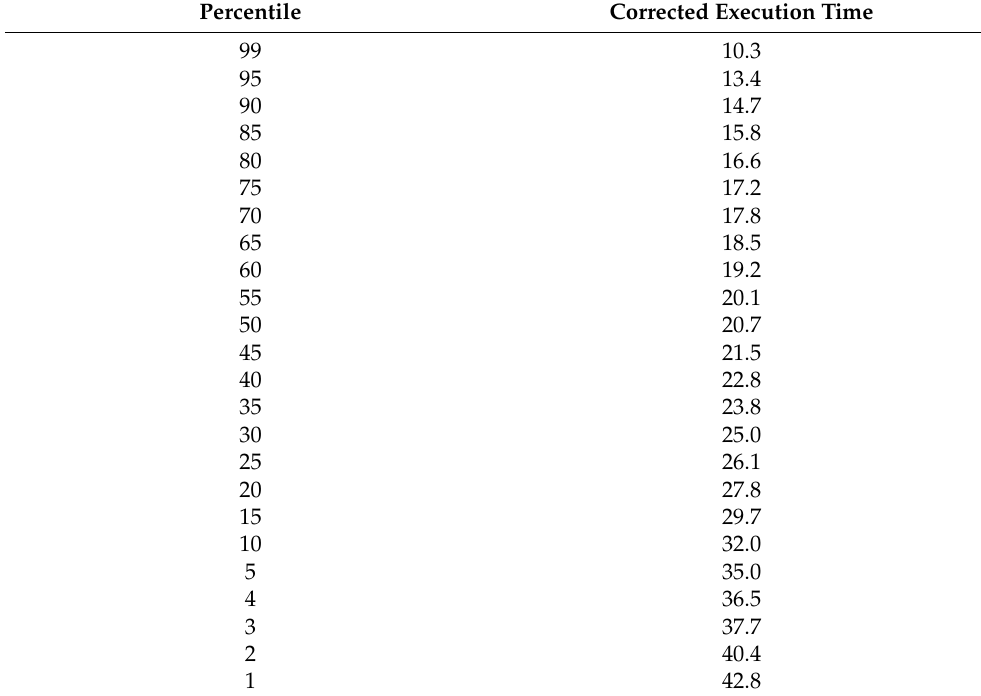
Table 12. Percentiles for corrected execution times.